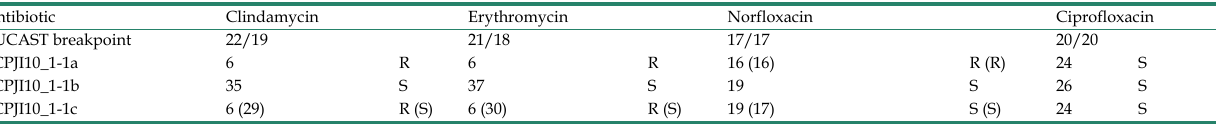
Table 1. Antimicrobial susceptibility testing (AST) using the disc diffusion test: zone size measured in millimetres followed by interpretation according to EUCAST (SIR) for the isolates. Zone diameters and interpretations in parenthesis represent the results from re-performing